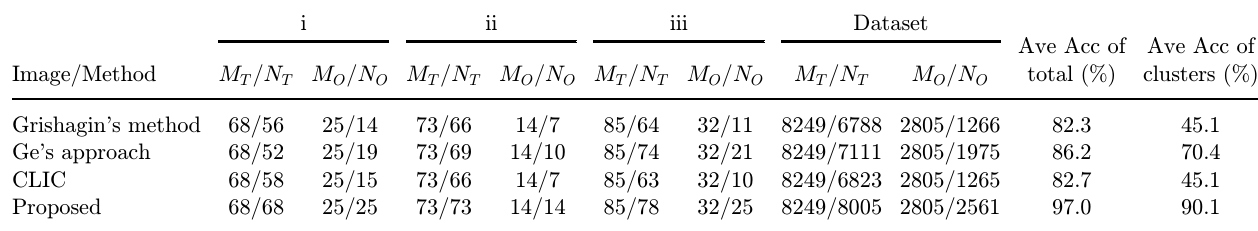
Table 3. Comparison with other